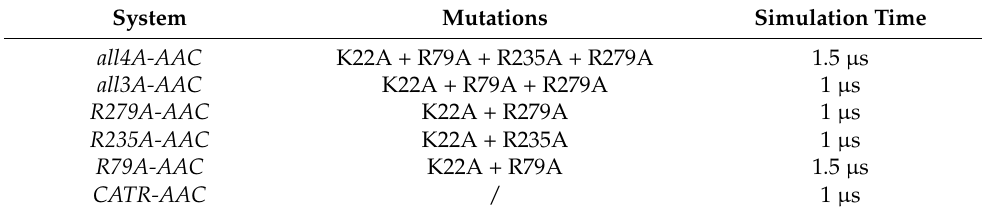
Table 1. Summary of simulations in the current work. System